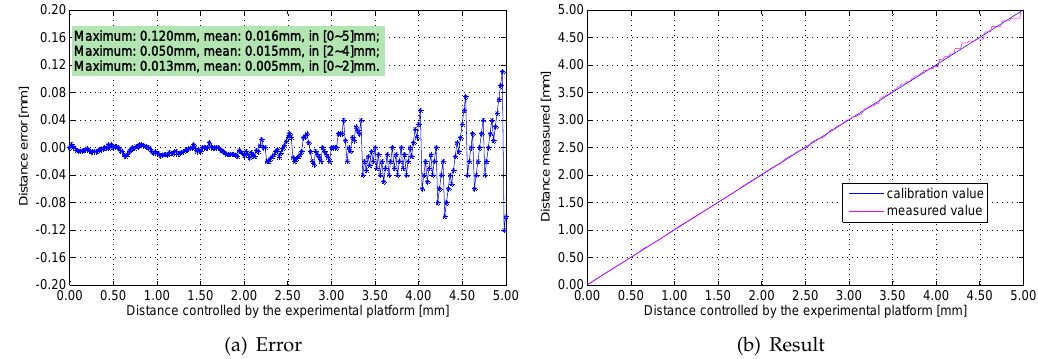
Figure 17. Measurement errors and results at 50 ◦ C.